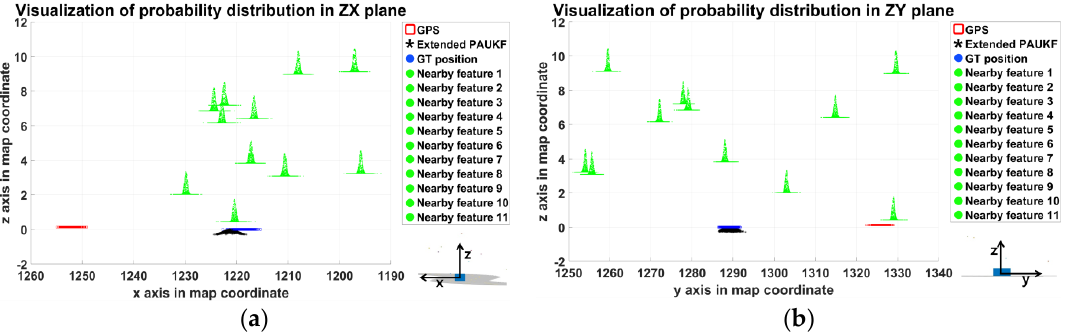
Figure 5. The probability distribution at 250th sample time. ( a ) Visualization of the probability of values at ZX plane; ( b ) visualization of the probability of values at ZY plane.